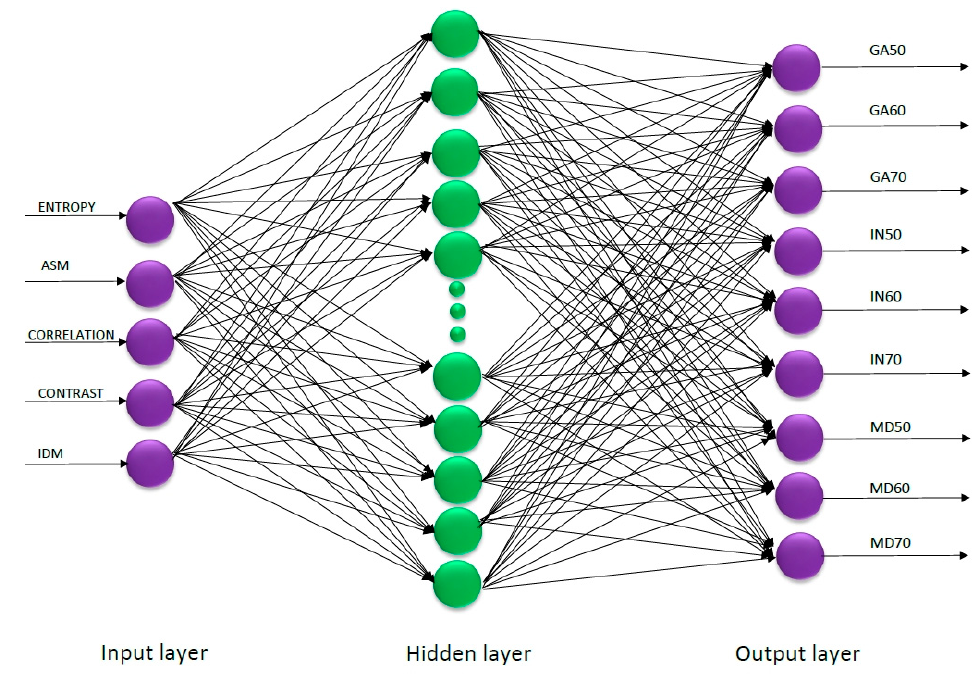
Figure 2. The structure of MLPN 5:5-24-9:1.